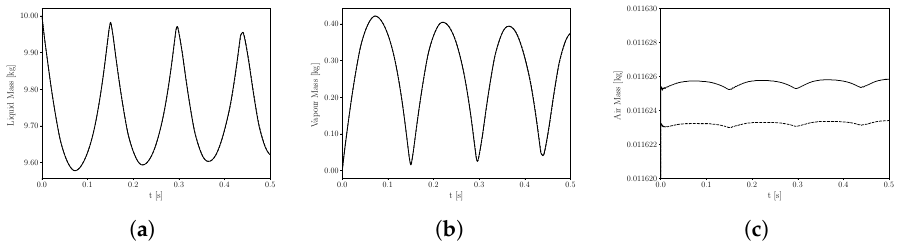
Figure 16. Temporal evolution of the mass for the i -th phase: ( a ) Liquid, ( b ) Vapour, ( c ) non- condensable gases. Legend: ( ) grid A (1